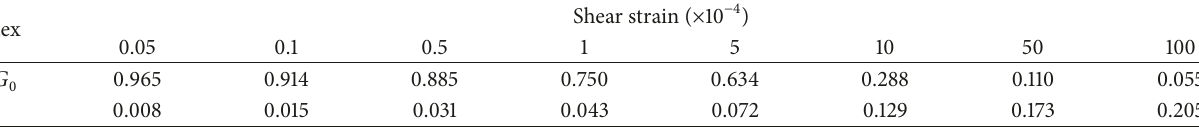
Table 1: The kinetic parameters of typical Lanzhou loess.